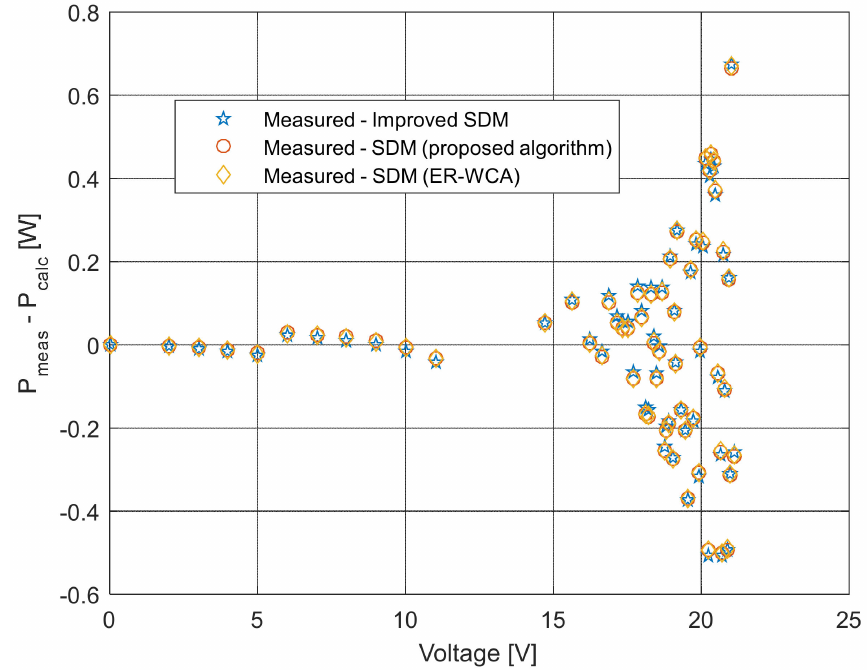
Figure 23. Difference between the measured and calculated power values using different methods for both SDM and ISDM.